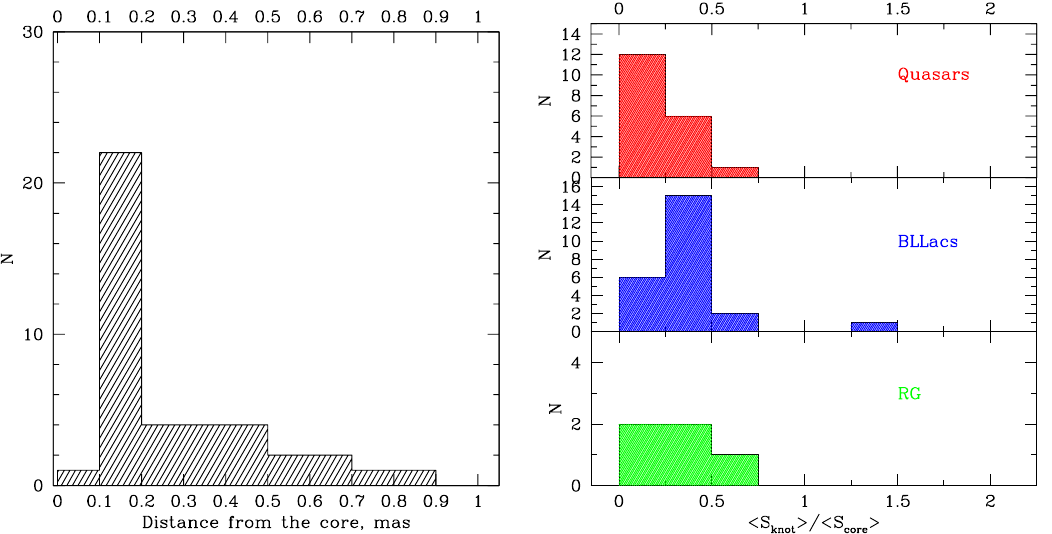
Figure 1. Left: Distribution of location of stationary components with respect to the core; Right: Distributions of the relative flux densities of stationary components for quasars, BL Lac objects, and radio